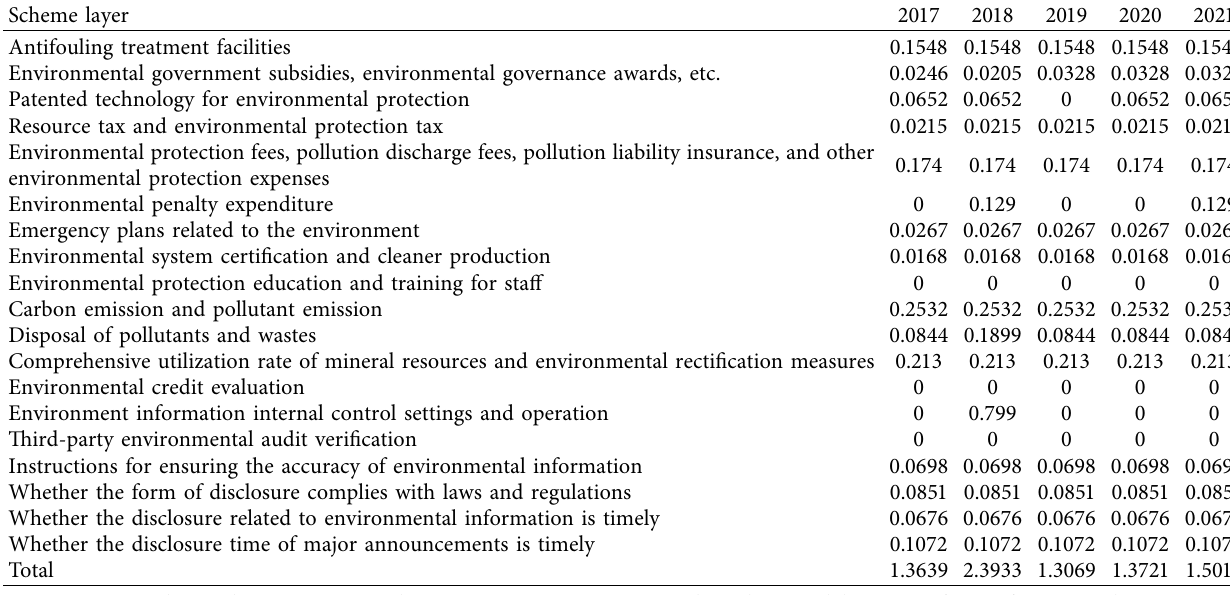
Table 13: Comprehensive score table of Y Company’s environmental accounting information quality from 2017 to 2021.